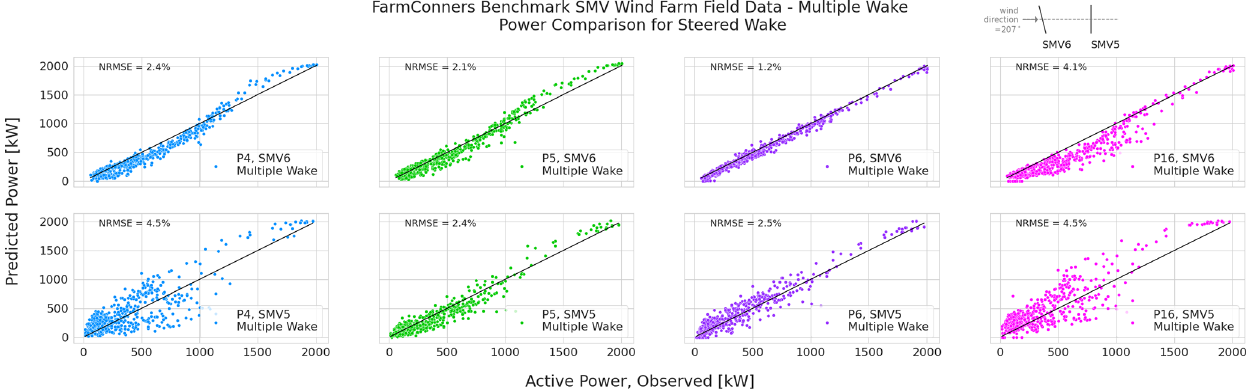
Figure A1. SMV WF field data, multiple wake under wake steering WFFC with − 13 . 3 ◦ upstream misalignment – power comparison. Representative layout with corresponding yaw control setting is illustrated at the upper right corner.